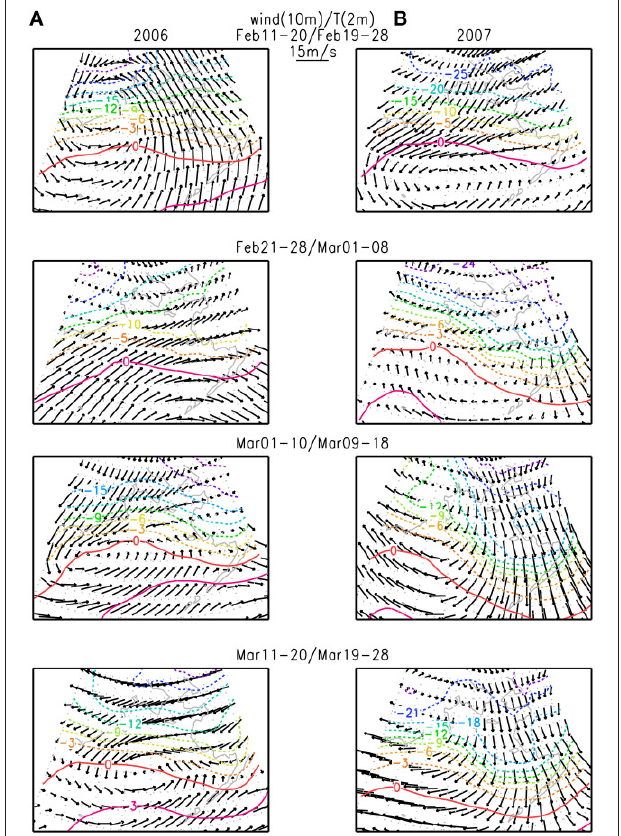
FIGURE 11 | Surface (10 m) winds (vector, scale at top-middle) and surface (2 m) air temperature (contour, interval: 3 ◦ C) in 2006 (A, left) and 2007 (B, right) during February 11–20, February 21–28, March 1–10, and March 11–20 for winds and during February 19–28, March 1–8, March 9-18, and March 19–28 for air temperature.